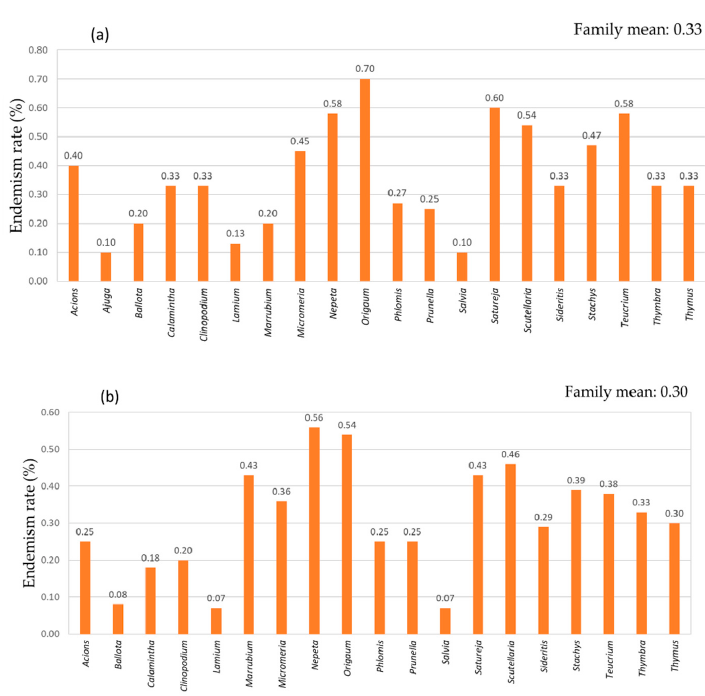
Figure 2. Endemism rates of Lamiaceae genera, at their species ( a ) and taxon ( b ) level.